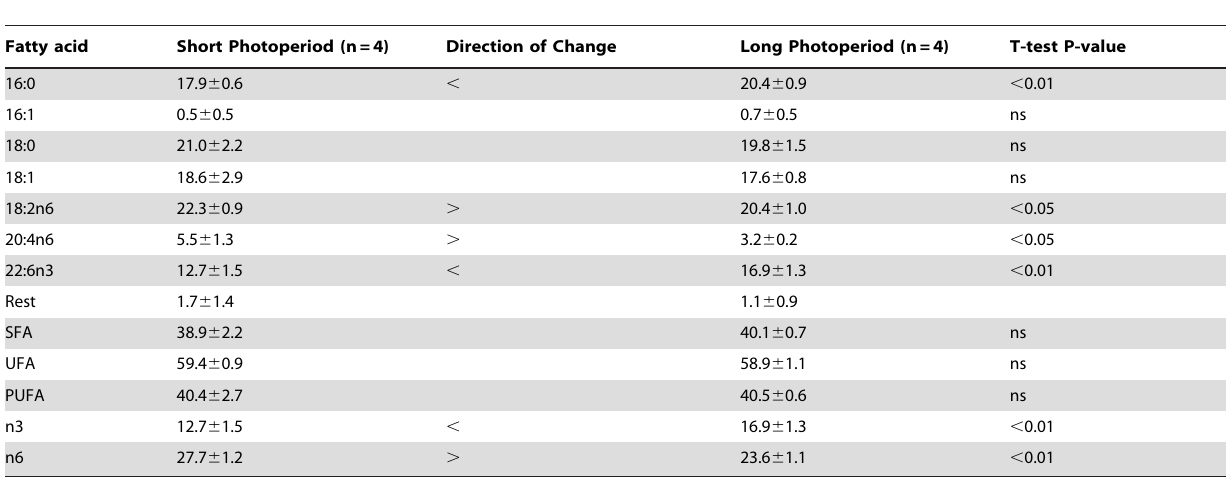
Table 4. Percent fatty acid composition ( . 0.1%) of heart muscle.